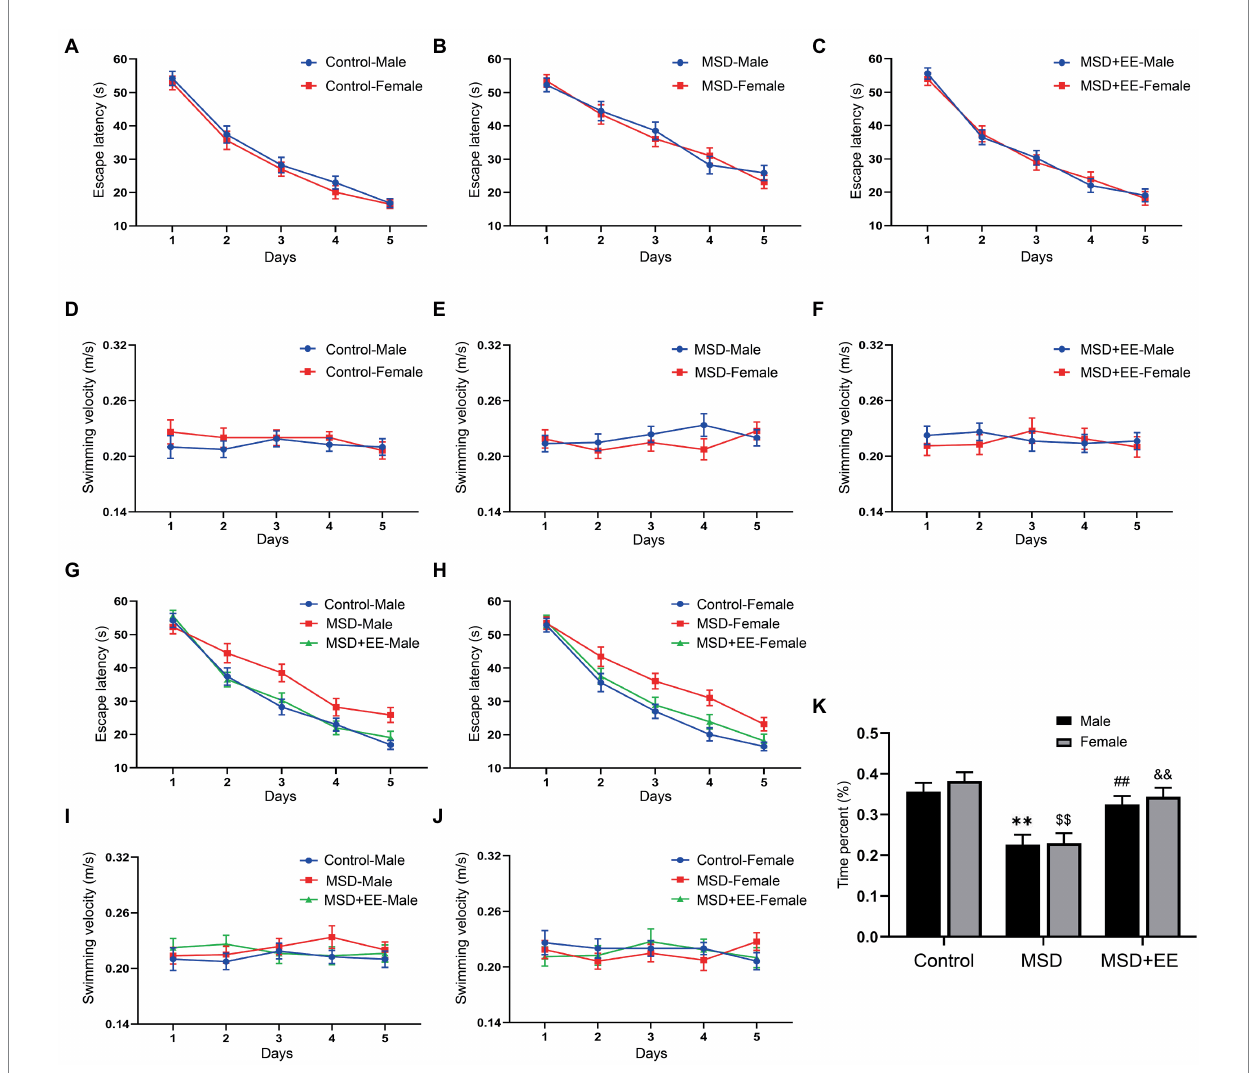
FIGURE 3 Effects of an environmental enrichment (EE) on spatial learning and memory impairment in elderly offspring mice exposed to maternal sleep deprivation (MSD). (A–C,G,H) Escape latency and (D-F,I,J) swimming velocity during the Morris water maze test. (K) Time spent in the target quadrant. ** p < 0.01 vs. Control group in males; $$ p < 0.01 vs. Control group in females; ## p < 0.01 vs. MSD group in males; && p < 0.01 vs. MSD group in